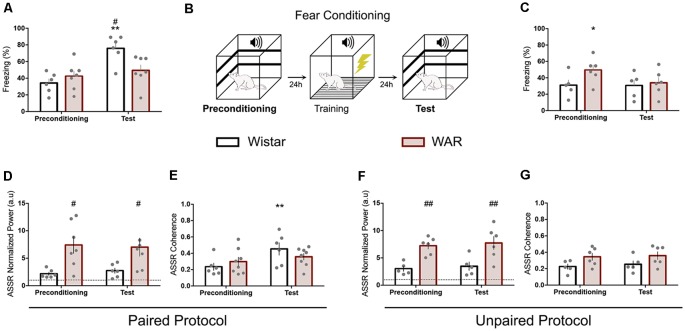
WAR animals presented similar behavioral and electrographic responses at the Auditory fear conditioning (AFC) phases. Fear conditioning task sequence (B) and freezing quantification for paired (A) and unpaired (C) protocol. Paired (D–F) and Unpaired (E–G) auditory ASSR power and coherence. The dashed lines at (D,F) represent the baseline value. *p < 0.05 and **p < 0.01 for session comparisons and #p < 0.05 and ##p < 0.01 for group statistical significance.